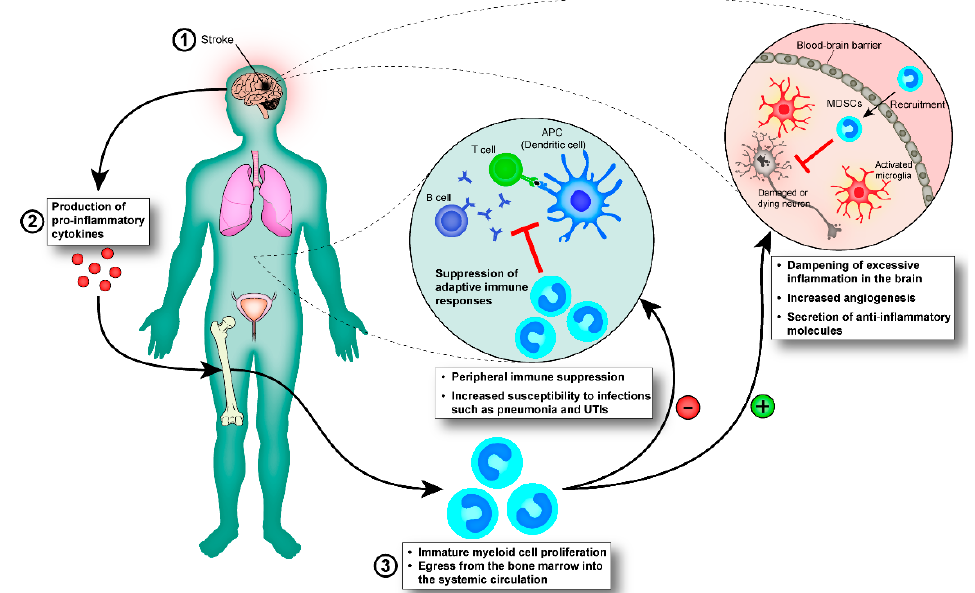
Figure 1. Immature myeloid cells mediate immune-suppression post-stroke. ( 1 ) Stroke is followed by ( 2 ) the production of pro-inflammatory cytokines, which reach the bone marrow via the blood-stream ( 3 ) where they stimulate the expansion of immature myeloid cells and partially block their maturation into granulocytes, macrophages, and DCs. The immature myeloid cells (also known as MDSCs) migrate along a chemokine/cytokine gradient to secondary lymphoid organs and to the infarction area where they exert anti-inflammatory effects on other cell populations. ( − ) Immature myeloid cells are able to suppress innate and adaptive immune responses in the periphery, exposing stroke patients to an increased risk of acquiring infections, such as pneumonia and urinary tract infections (UTIs), which impede recovery and can potentially be life-threatening. (+) We hypothesise that immature myeloid cells travelling from the bone marrow to the brain exert protective effects there. Immature myeloid cells are highly phagocytic and would help clearing the infarct area of dead cells, and they are known to dampen inflammation through the secretion of cytokines that skew innate immune cells towards an anti-inflammatory phenotype. Furthermore, they are able to induce angiogenesis through the secretion of MMPs, which facilitates re-vascularisation. All of these effects would be beneficial, acting to limit excessive inflammation and promote healing. MMPs, matrix metalloproteinases.